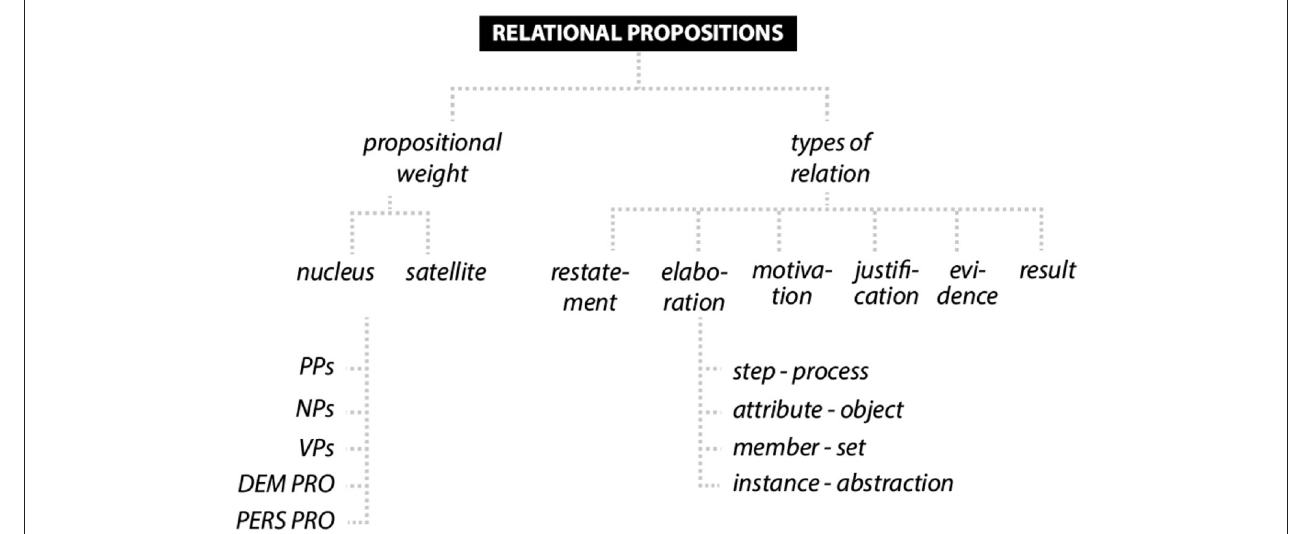
FIGURE 6 | Taxonomic overview of concepts for an analysis of relational propositions in print